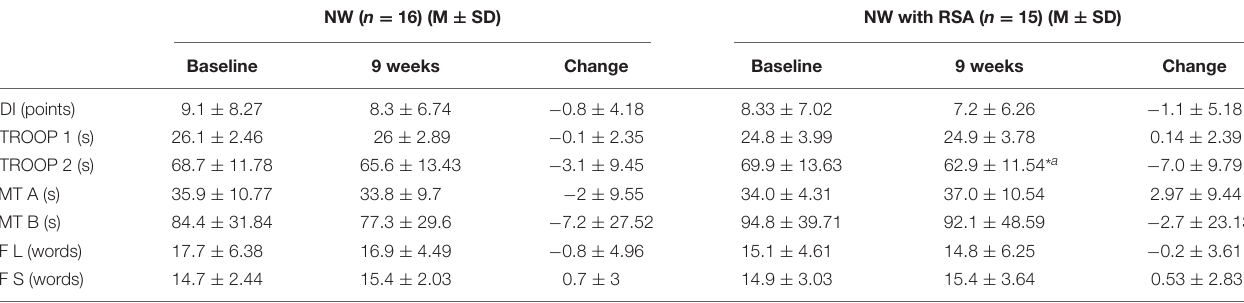
TABLE 2 | Cognitive and mental health outcomes in response to the intervention